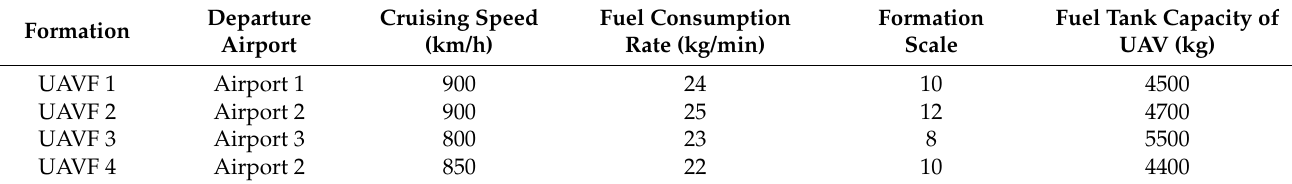
Figure 10. The URMFTG scenario. Table 2. UAVF parameters.